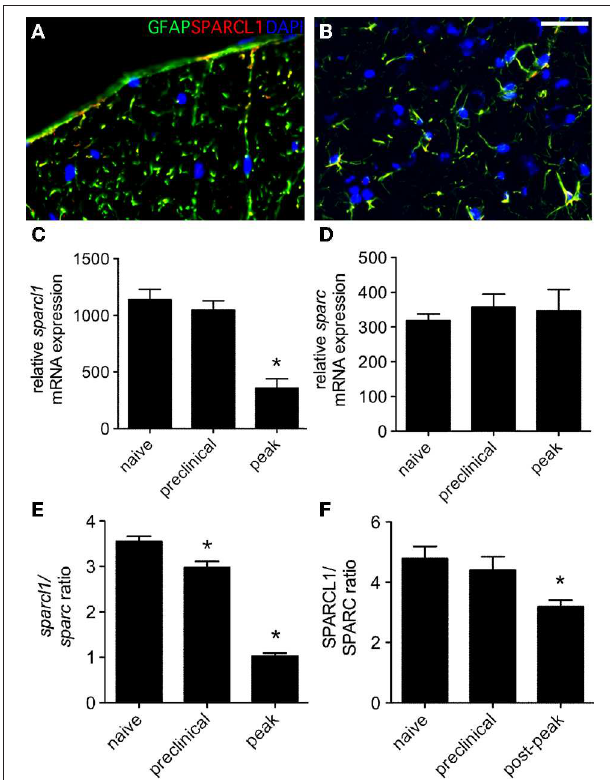
FIGURE 5 | Expression of sparcl1 and sparc transcripts and SPARCL1 and SPARC proteins changes in lumbar spinal cord tissue over the course of non-relapsing EAE in C57BL/6 mice. (A,B) Representative immunofluorescence shows SPARCL1 expression co-localizes with GFAP staining in both white and gray matter of the spinal cord, Bar = 40 µ m. (C) Relative sparcl1 mRNA expression fluxes over the course of non-relapsing EAE ( n = 5 mice per disease stage). (D) Relative sparc mRNA expression does not change over the course of non-relapsing EAE ( n = 5 mice per disease stage). (E) The calculated sparcl1 to sparc mRNA expression ratio shifts in favor of synapse inhibition at peak disease. (F) A similar change in the SPARCL1 to SPARC protein concentration ratios is seen over the course of non-relapsing EAE ( n = 5 mice per disease stage). * p < 0.05 compared to levels found in naïve spinal cord.